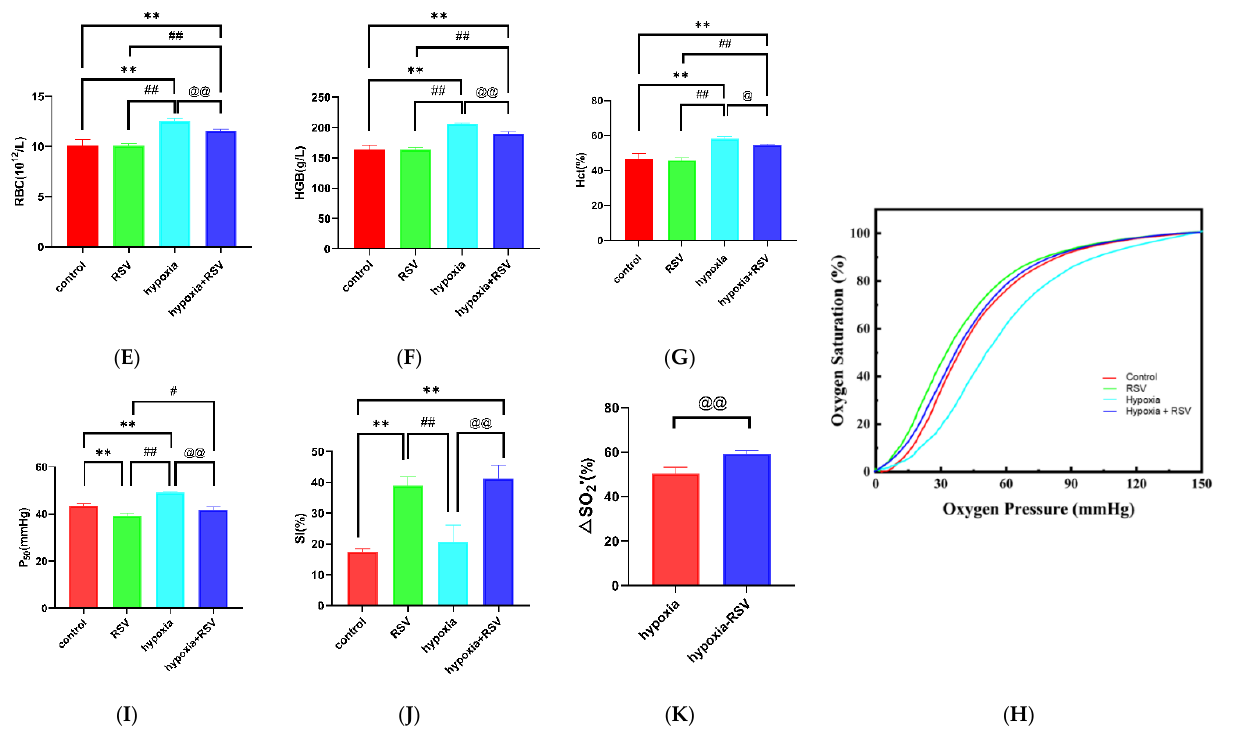
Figure 5. Hypoxic adaption of mice treated with RSV: changes in body weight ( A ), arterial blood gas analysis results for the partial pressure of oxygen (PO 2 ) ( B ), arterial oxygen saturation (SO 2 ) results ( C ), lactate counts ( D ), blood cell analysis results for counts of red blood cells (RBCs) ( E ), hemoglobin volume (HGB) values ( F ), counts of hemoglobin (Hct) ( G ), oxygen dissociation curves ( H ), P 50 values ( I ), SI ( J ), and ∆ SO 2 ′ values ( K ) after 7 days in the control group, normoxia with RSV group, hypoxia group, and hypoxia with RSV group. Note: *, vs. control group, p < 0.05; **, vs. control group, p < 0.01; #, vs. normoxia with RSV group, p < 0.05; ##, vs. normoxia with RSV group, p < 0.01; @, vs. hypoxia group, p < 0.05; @@, vs. hypoxia group, p < 0.01; aa, vs. control-7d group, p < 0.01; bb, vs. normoxia with RSV group, p < 0.01; cc, vs. hypoxia group, p < 0.01.